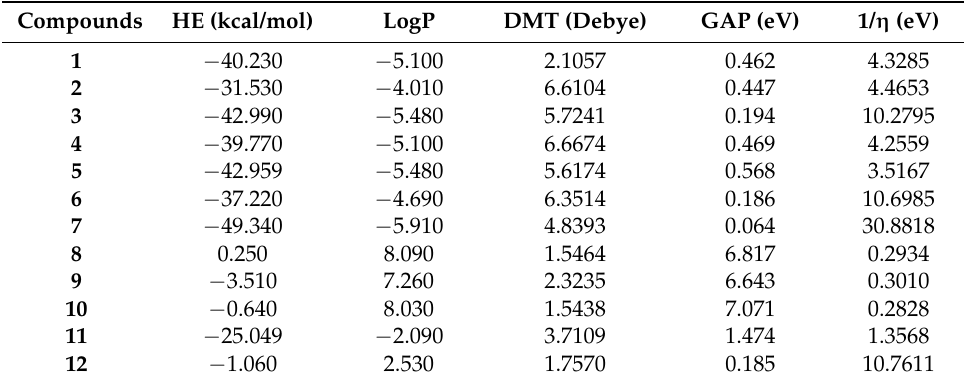
Table 1. Descriptors most relevant for the principal component